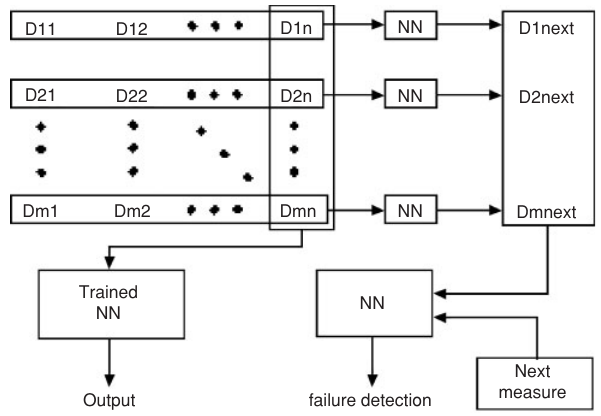
Figure 3 Fusion and sensor failure